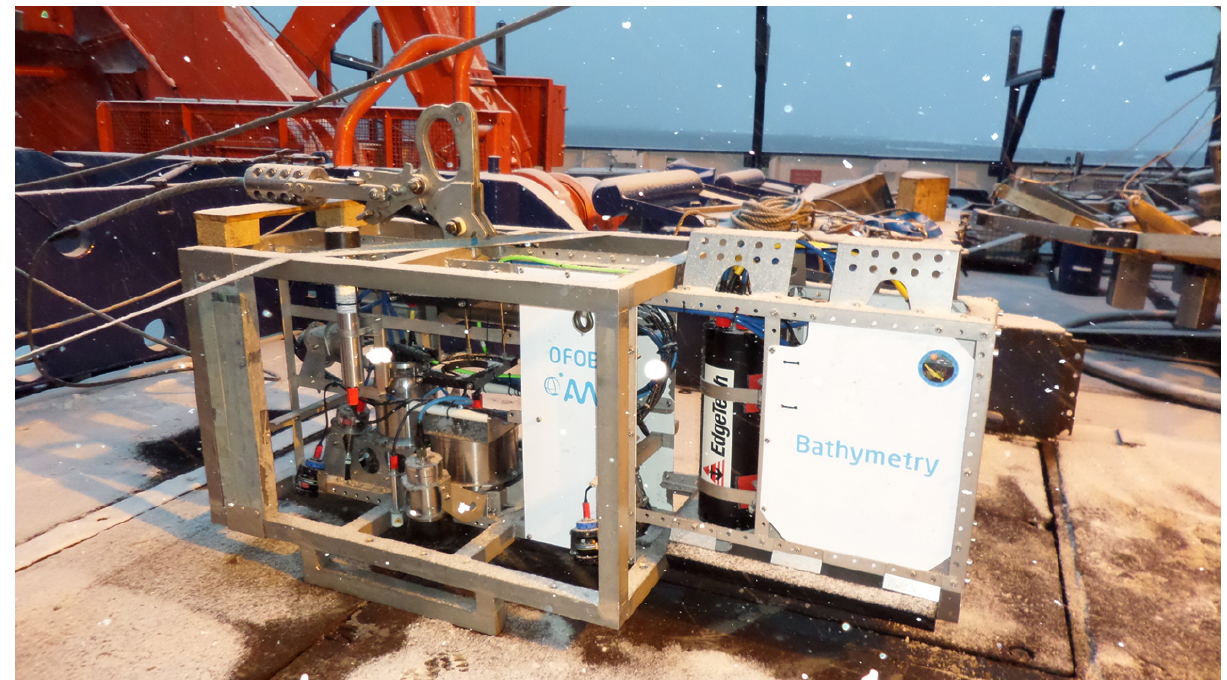
Figure 1. The Ocean Floor Observation and Bathymetry System (OFOBS) of the Alfred Wegener Institute (AWI), Helmholtz Centre for Polar and Marine Research, on deck awaiting deployment during the PS124 expedition to the southern Weddell Sea (February–March